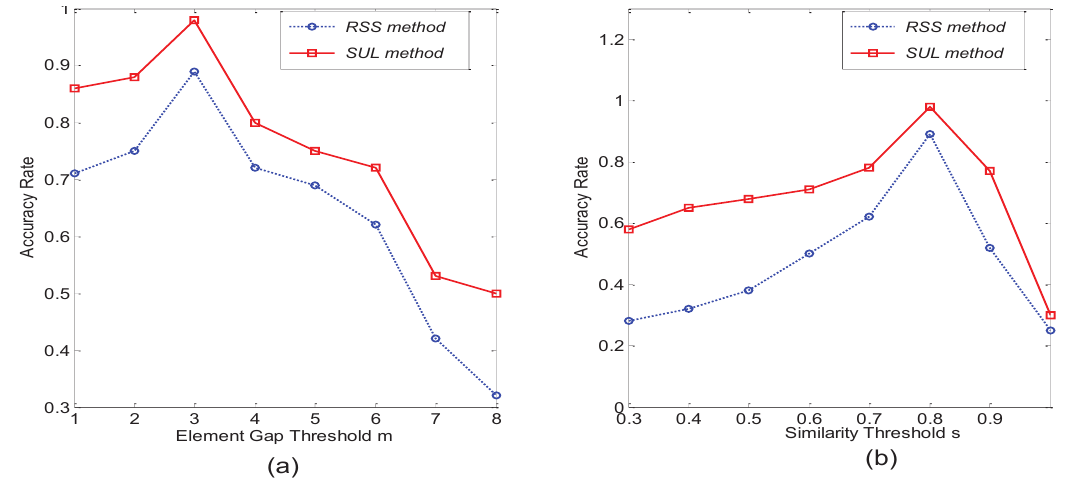
Figure 9. Investigation on system parameters. ( a ) For element gap threshold m ; ( b ) for similarity threshold s